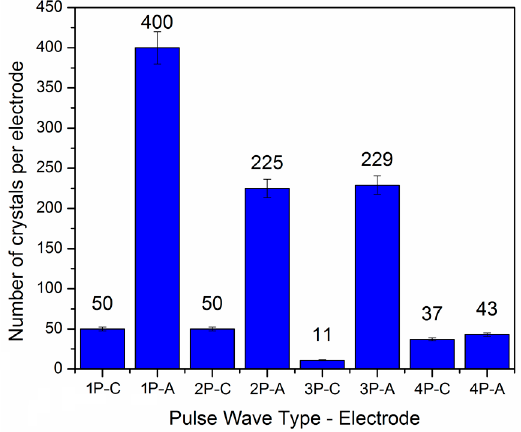
Figure 3. The pulse (P) wave number corresponds to the type of wave-pulse (I to IV mentioned in the text). This shows the number of crystals attached to the anode (A) or to the cathode (C).